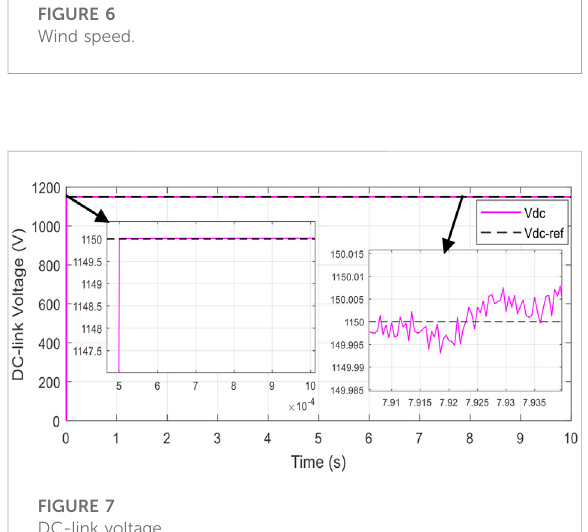
FIGURE 7 DC-link voltage.